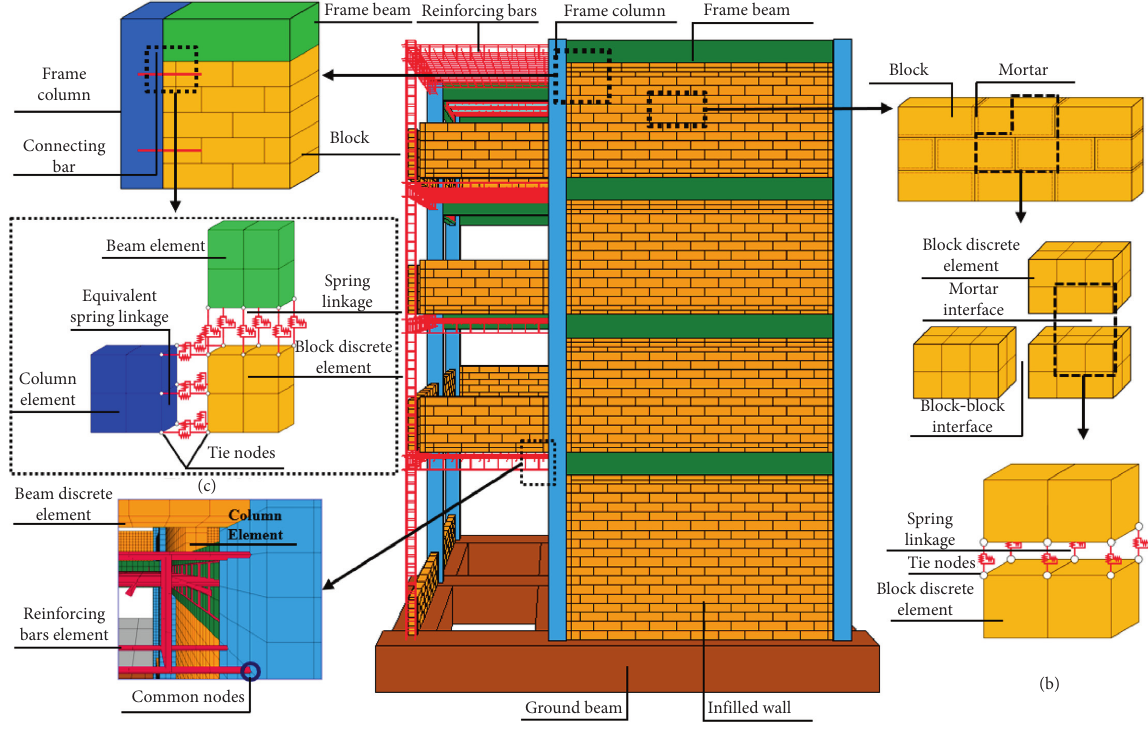
Figure 19: Modeling scheme of RC frame structure with infilled wall.